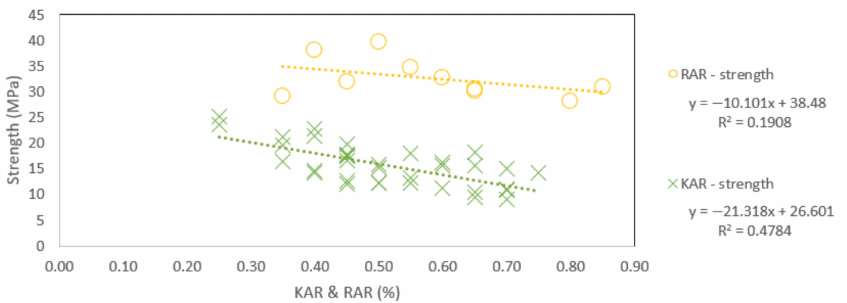
Figure 30. KAR and RAR vs. tensile